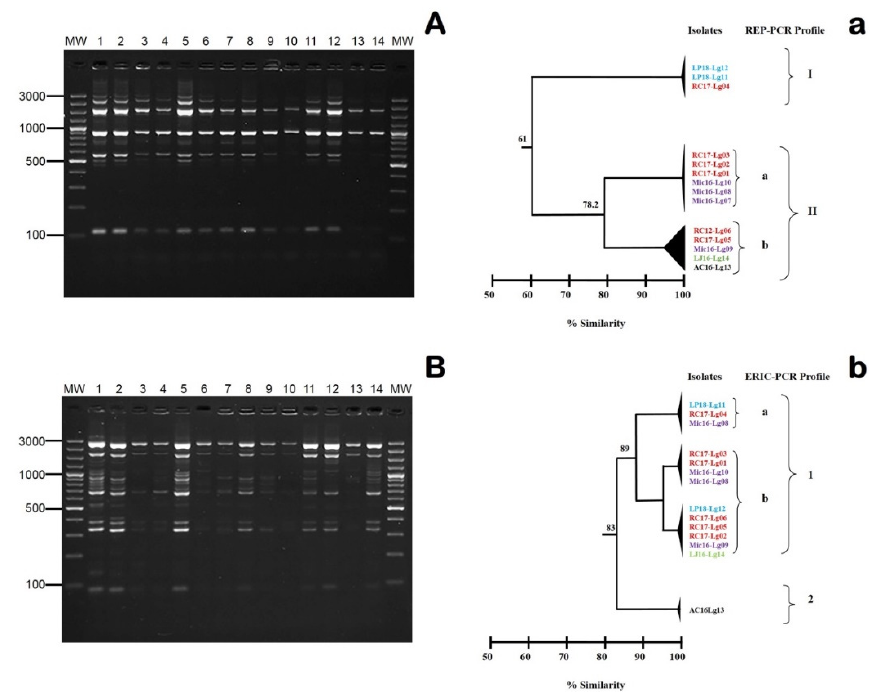
Figure 4. ( A ) Repetitive extragenic palindromic PCR (REP-PCR) and ( B ) enterobacterial repetitive intergenic consensus sequence PCR (ERIC-PCR) fingerprinting obtained for the 14 Mexican L. garvieae isolates. Lanes: MW, AccuRuler 100 bp Plus DNA RTU Ladder (Maestrogen); 1, AC16-Lg13; 2, LJ16-Lg14; 3, Mic16-Lg07; 4, Mic16-Lg08; 5, Mic16-Lg09; 6, Mic-Lg10; 7, RC17-Lg01; 8, RC17-Lg02; 9, RC17-Lg03; 10, RC17-Lg04; 11, RC17-Lg05; 12, RC-Lg06; 13, LP18-Lg11; and 14, LP18-Lg12 correspond to the numerical code of DNA extracted from each isolate. Numbers on the left indicate the position of the molecular-size marker in bp. Dendrograms were established by the GelJ software (Java Application) using the Dice similarity coefficient and the unweighted average pair group method on the basis of the ( a ) REP and ( b ) ERIC profiles. Codes in the same colors indicate isolates obtained from the same Mexican farm. Numbers along the branches indicate % similarity.